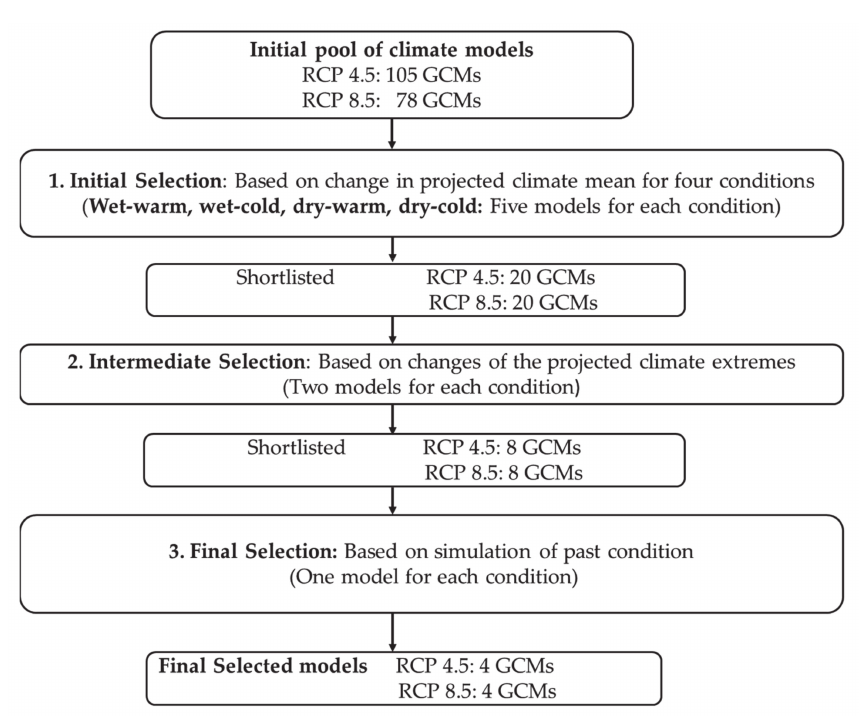
Figure 2. Climate model selection (adopted and modified from